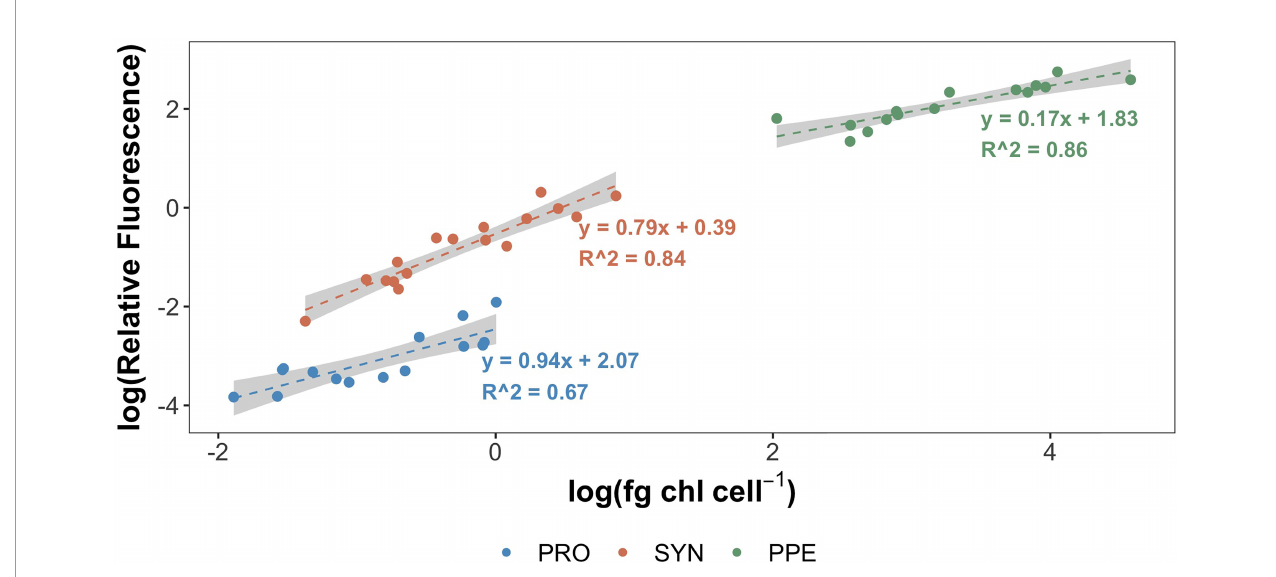
FIGURE 4 | Log-transformed per-cell Chl a (fg Chl a cell -1 ) for Prochlorococcus (blue), Synechococcus (orange), and picophytoeukaryotes (green) plotted against log-transformed relative red fl uorescence measured by BD In fl ux cytometer. Grey shading corresponds to ± 1 standard error of regression coef fi cients. All samples processed 2 – 8 months following sample collection.